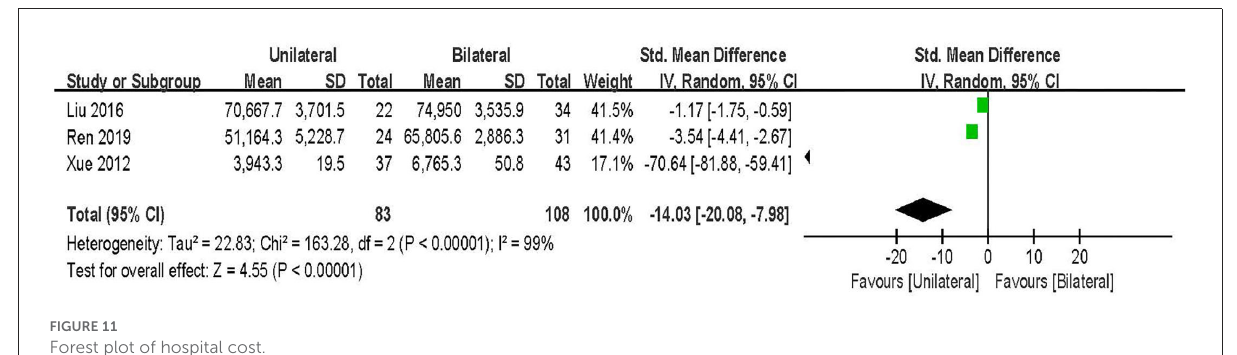
FIGURE11 Forest plot of hospital